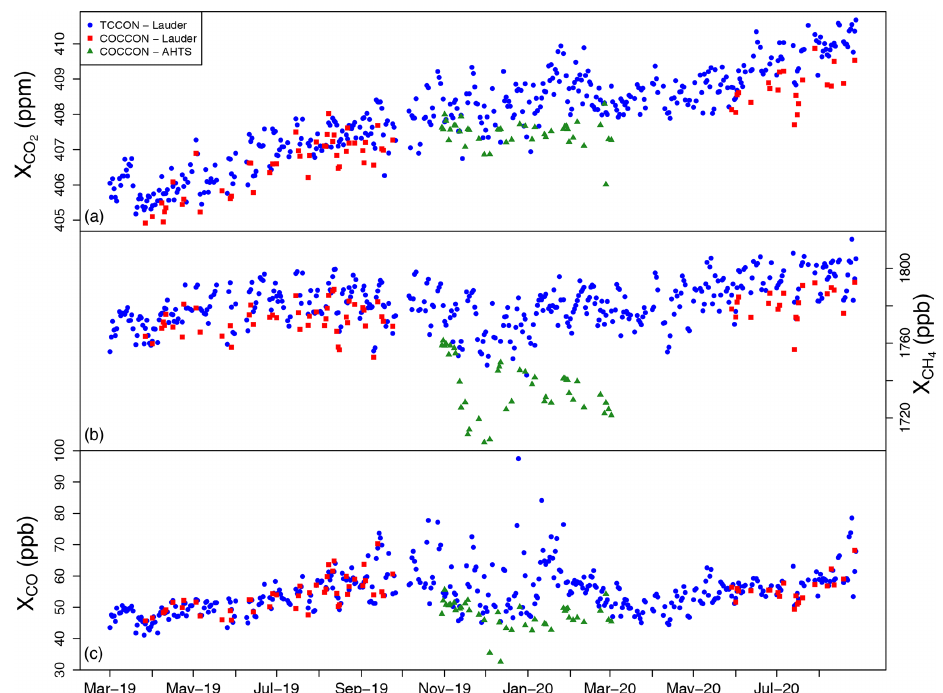
(a) , X CH (b) and X CO (c) retrieved from spectra measured using the Lauder TCCON 2 4